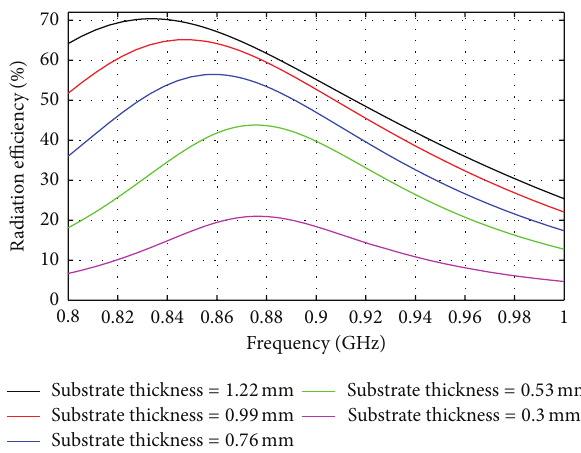
Figure 9: Radiation efficiency as a function of patch substrate